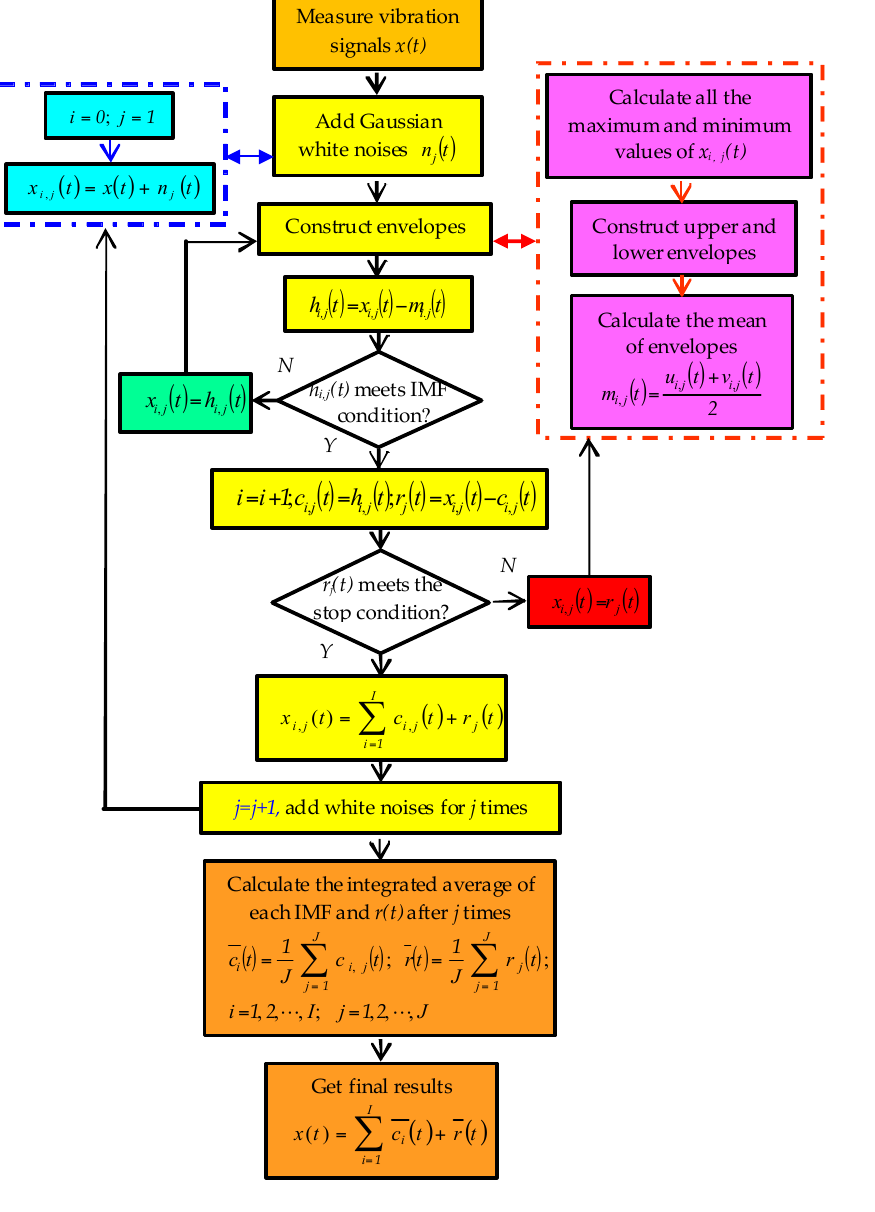
Figure 2. Flowchart of EEMD.